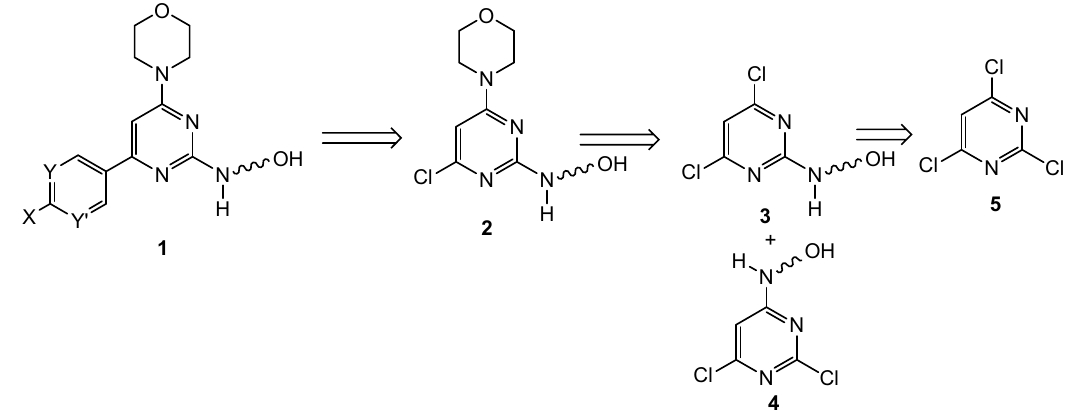
Scheme 1. Retrosynthesis of trisubstituted pyrimidines.